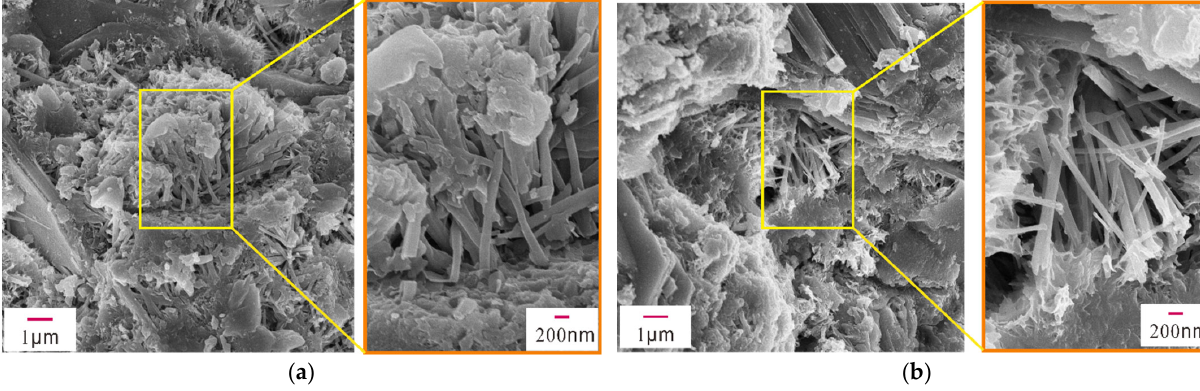
Figure 8. SEM images of sample 10N. ( a ) Partial SEM image of sample 10N, ( b ) Partial SEM image of sample 10N.